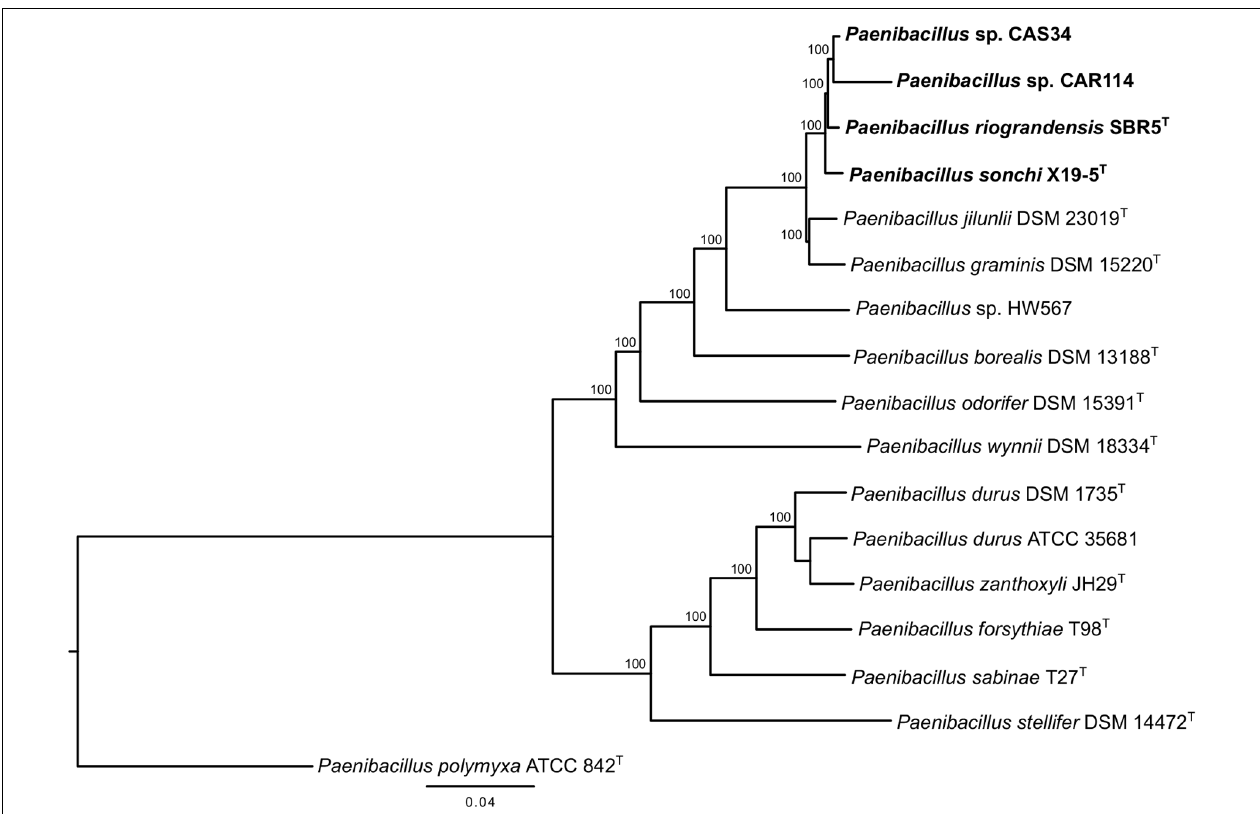
FIGURE 7 | Core-proteome phylogeny of Paenibacillus species. The core-proteome rooted tree was constructed using the Neighbor Joining method. Details are as shown in Figure 1 , unless specified otherwise. Bootstrap values greater than 70% are shown next to the